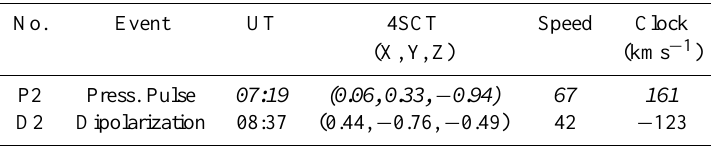
Table 1. The outputs of four-spacecraft timing analysis (4SCT) of the magnetic field data from Cluster. The clock angle (angle between the Z and Y components) of the 4SCT vector is